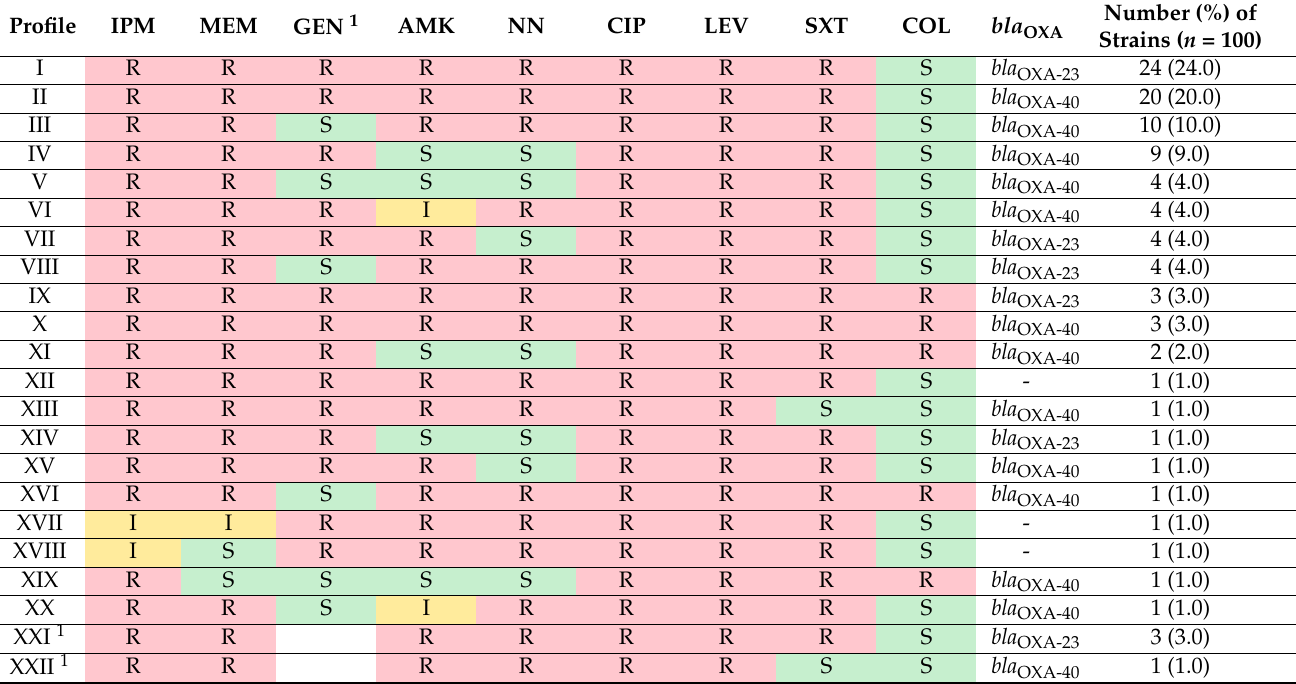
Table 3. Distribution of susceptibility profiles and oxacillinases genes among A. baumannii strains included into the study ( n =